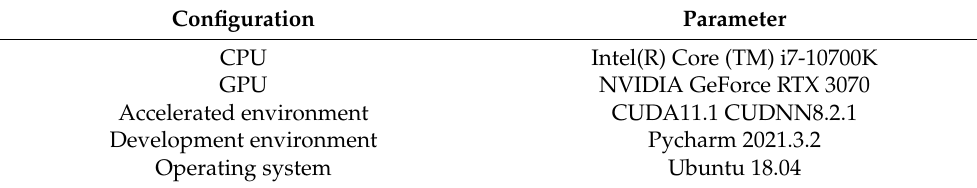
Table 4. Experimental